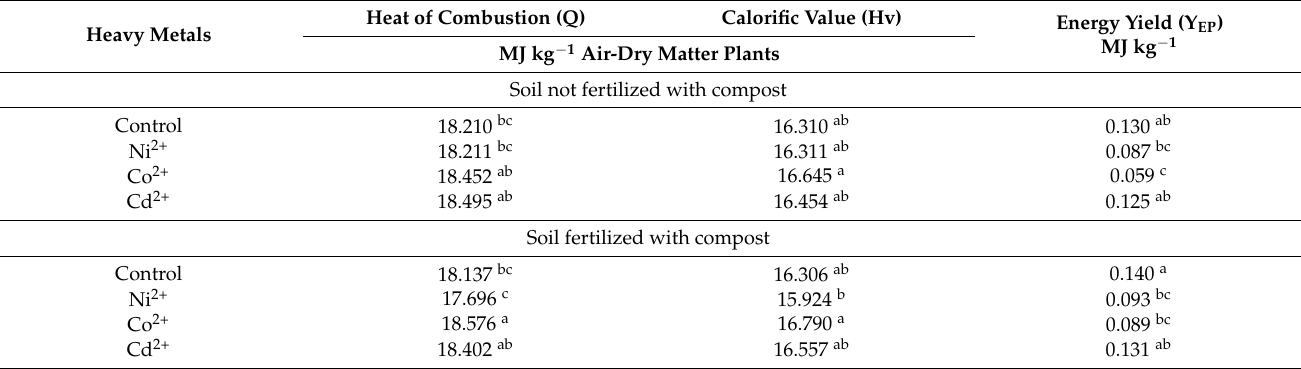
Table 3. Heat of combustion and calorific value of Festuca rubra